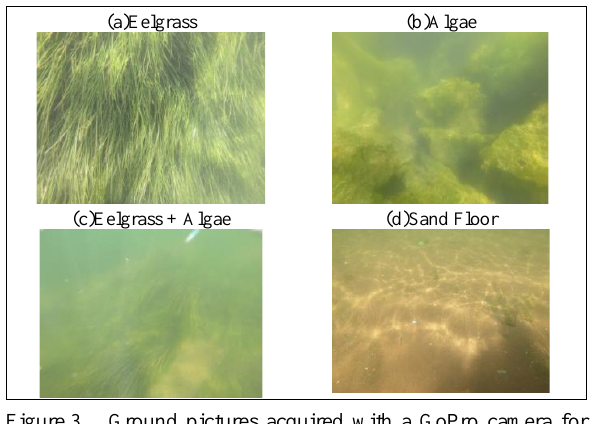
Figure 3. Ground pictures acquired with a GoPro camera for the following classes: a) eelgrass, b) algae, c) eelgrass and algae, and d) sand floor.